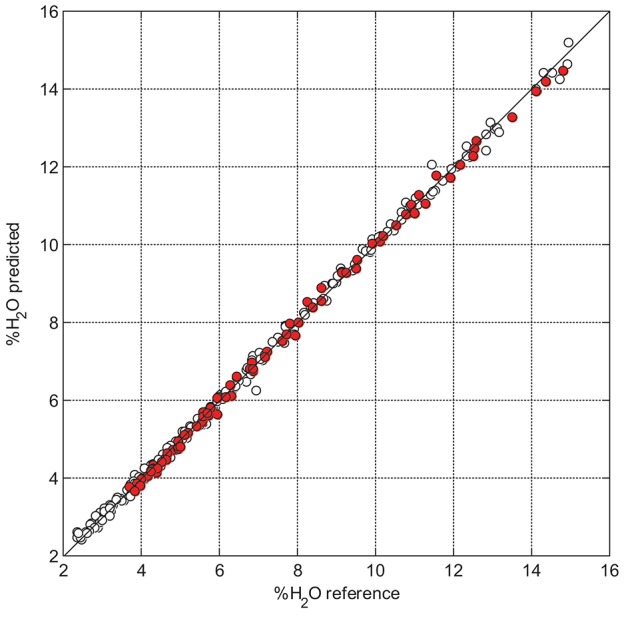
PLS predicted (7 LVs) vs. measured moisture content for D15 with 15-point smoothing; calibration and validation samples are presented by hollow and red-filled markers, respectively.